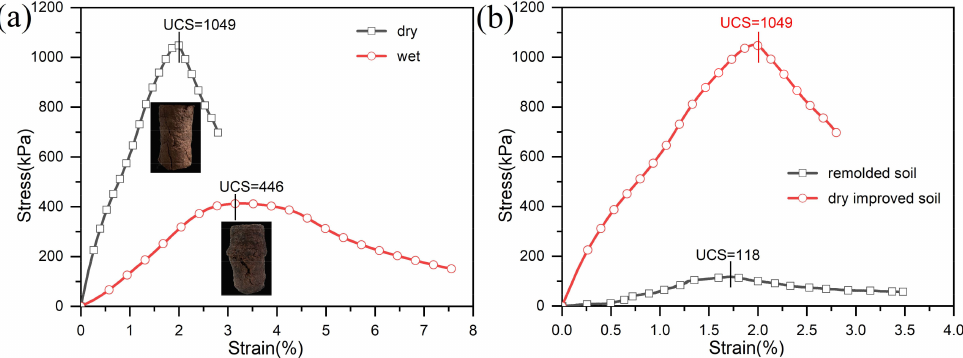
Figure 9. Stress–strain curve of samples: ( a ) improved sample before and after immersion; ( b ) sample before and after improvement.